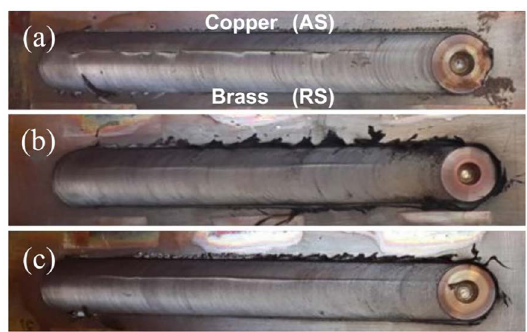
Figure 4. Surface images of lap joints between copper and brass alloys in case A with the condition of (a) 450 rpm- 16 mm/min